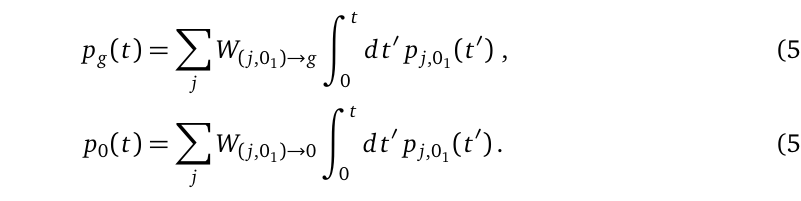
Figure 10: Exact final occupation p of the two ground states in the even parity subspace as a function of the initial excited 〉 (even parity) with J ( 2 ) state | i ,0 1 dashed line corresponds to the energy E